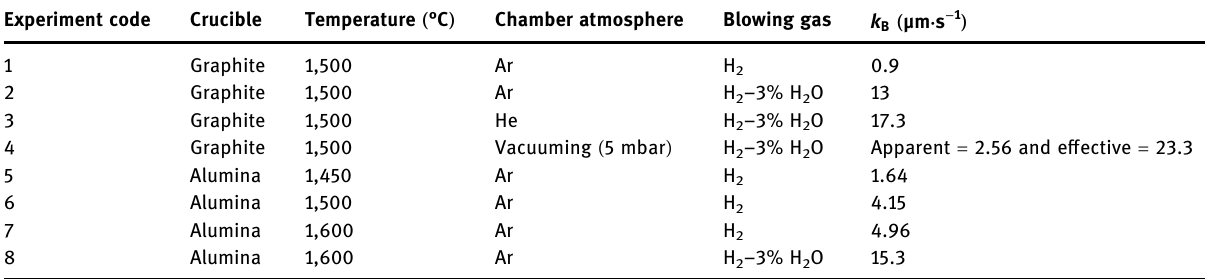
Table 4: The results from gas re fi ning in various crucibles Experiment code